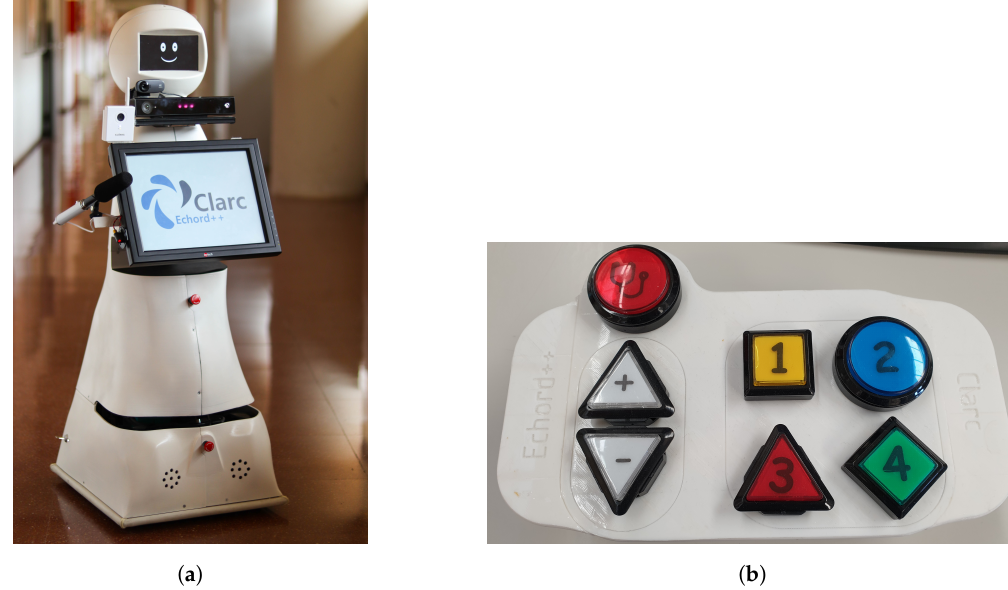
Figure 3. ( a ) The CLARC robot; and ( b ) External device used for interacting with the